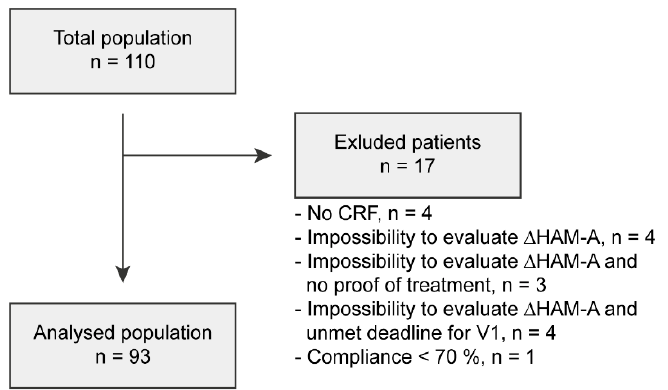
Figure 2. Number of patients included in the study, excluded and analysed. CRF: case report